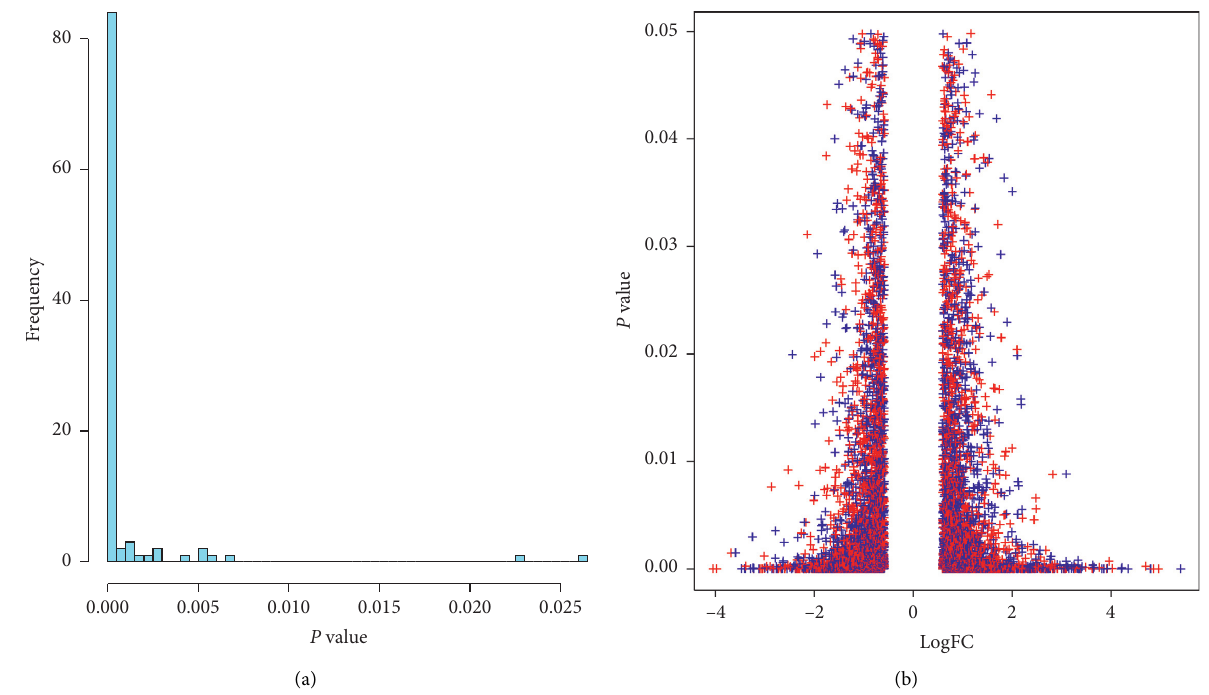
Figure 6: The genes number distribution of P < 0 . 05 and the correlation LogFC and P